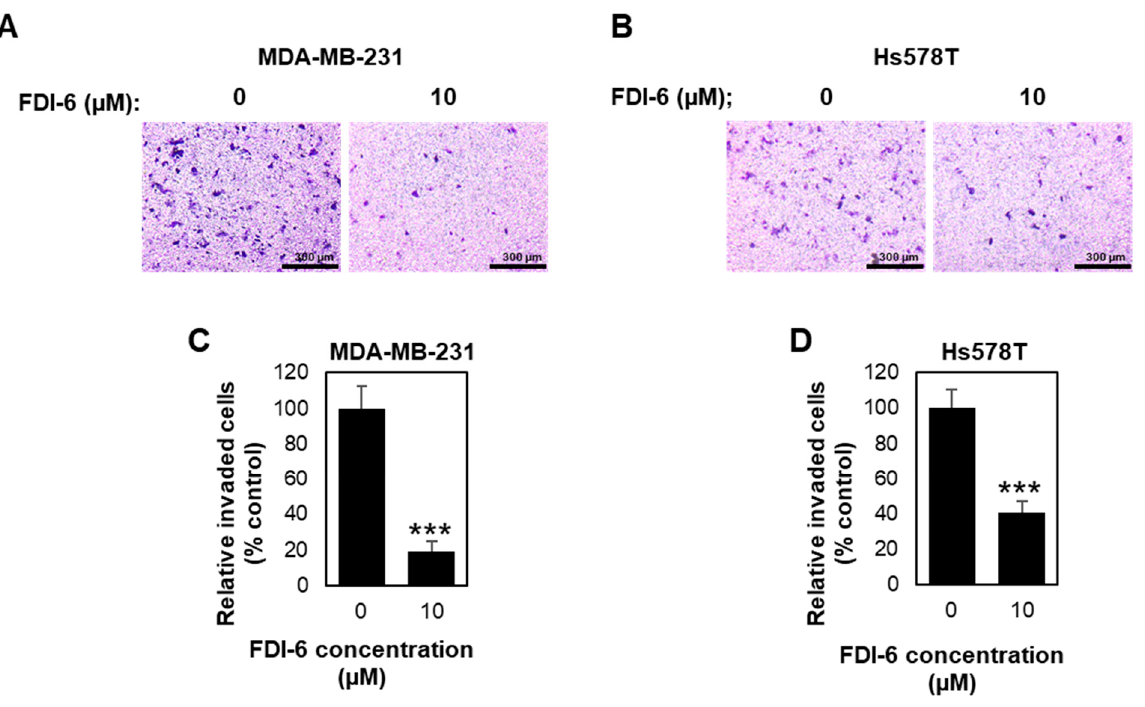
Figure 5. FDI-6 suppressed the invasion of TNBC cells. ( A , B ) Representative image from the Transwell invasion assay of the ( A ) MDA-MB-231 and ( B ) Hs578T cells after being treated with 0 µM and 10 µM FDI-6 for 24 h; ( C , D ) The bar graphs represent the average relative invasion of ( C ) MDA-MB-231 and ( D ) Hs578T cells in comparison with the control from three independent experiments ± S.D. ( n = 3). Statistical significance was determined by Student’s t -test (significant, *** p < 0.001).